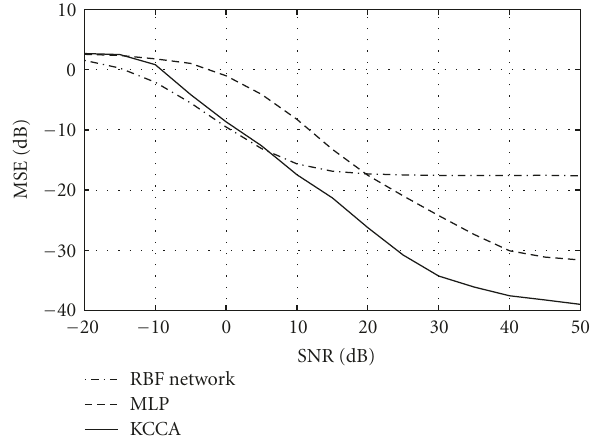
Figure 7: Full identification MSE (cid:2) e y (cid:2) 2 of the Wiener system, using two black box methods (RBF network and MLP) and the proposed KCCA algorithm.